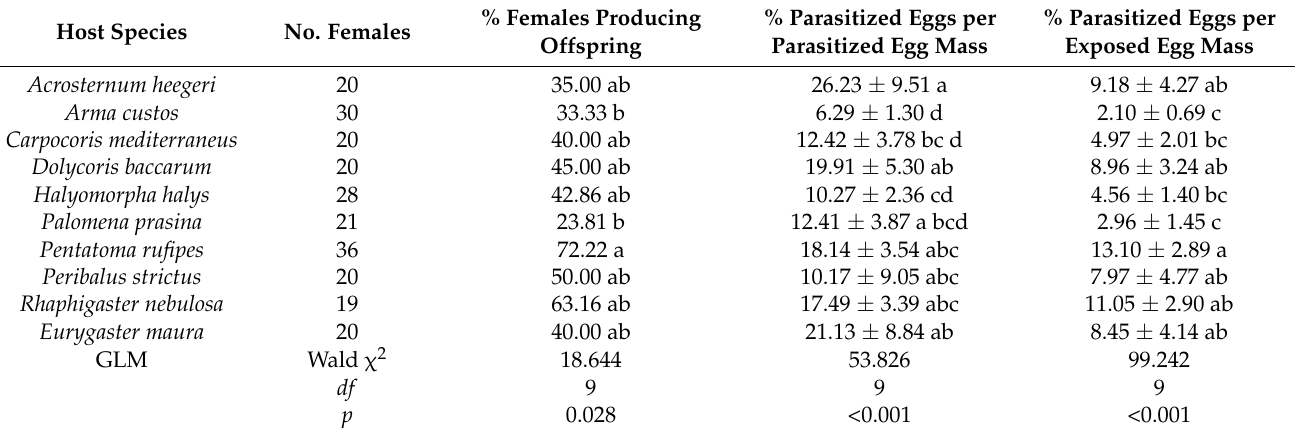
Table 3. Offspring production on Halyomorpha halys eggs of Trissolcus kozlovi females emerged from different host species: percentage of females producing offspring, mean percentage ( ± SE) of offspring emergence within each parasitized egg mass and within each exposed egg mass. In column, values followed by the same letter are not significantly different (Bonferroni test, p < 0.05, under GLM procedure with binomial distribution and logit link).